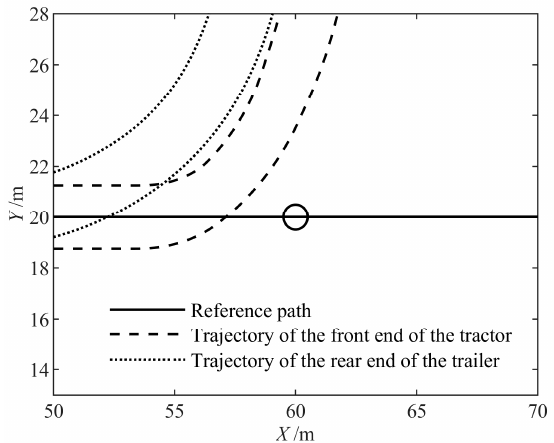
Figure 17. The trajectory of the obstacle avoidance controller based on the circumcircle model in the second group of simulations.